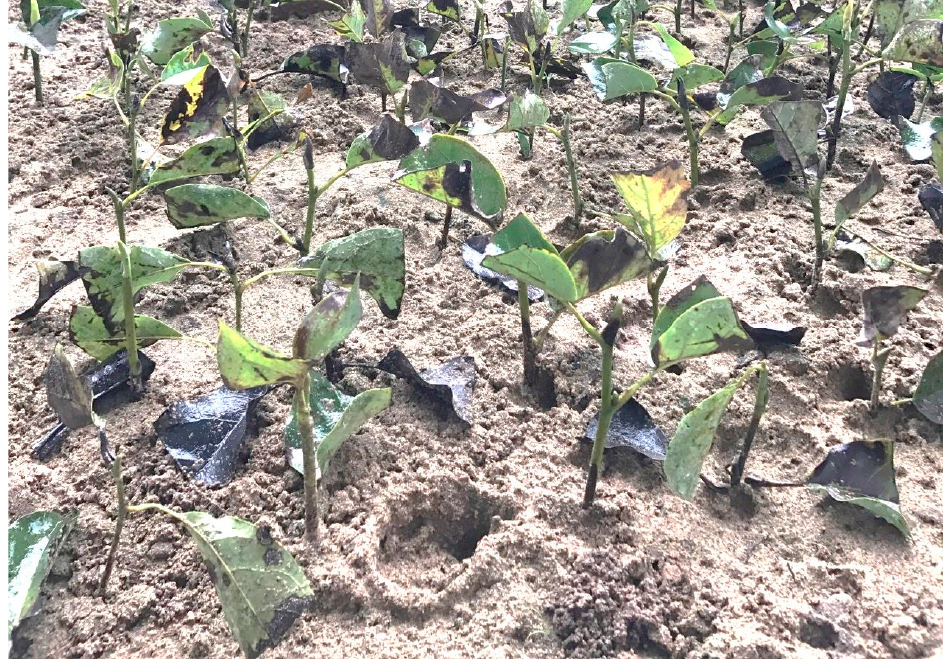
Figure A3. Cuttings in Control gradually rotted and almost completely rotted at 58 days after planting.